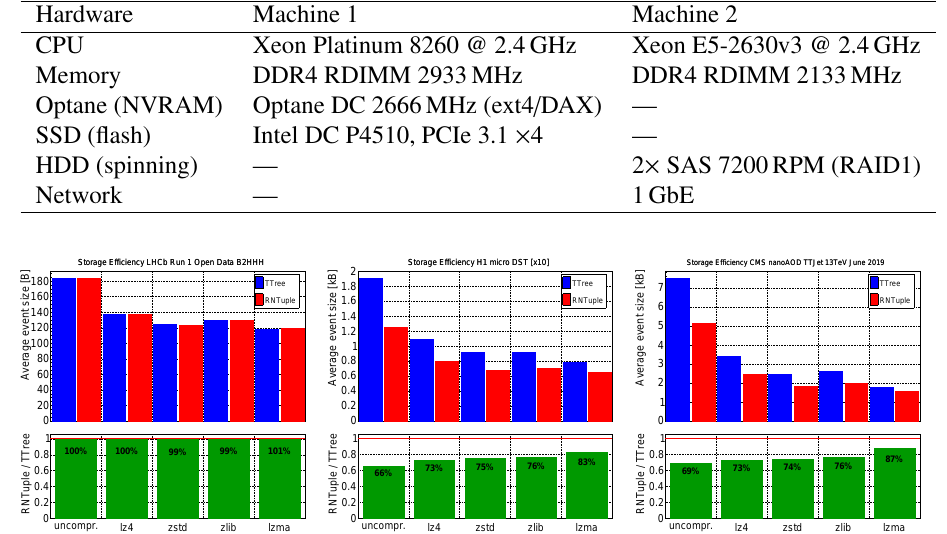
Figure 4. File size comparison of the sample analysis input data in TTree and RNTuple format with di ff erent compression algorithms.